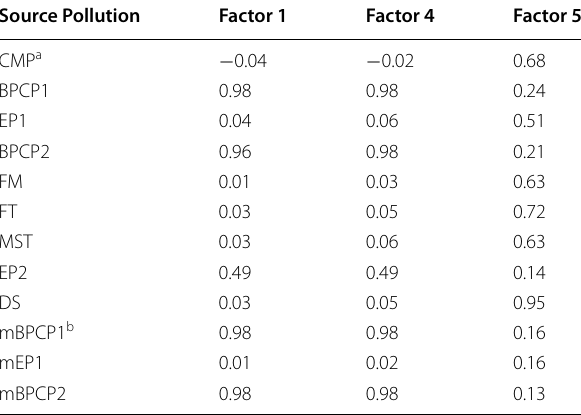
Table 2 Correlations of Factors 1, 4, 5, with all source